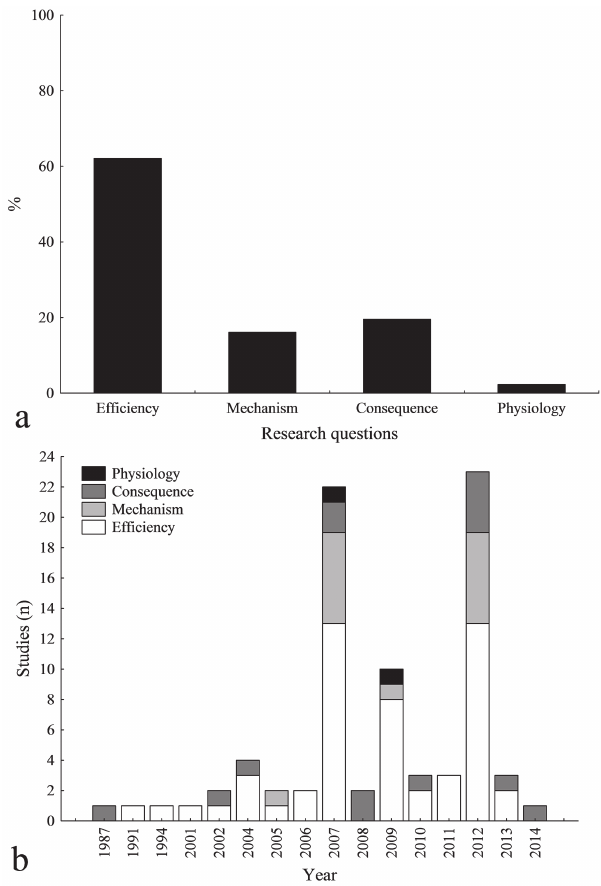
Fig. 7. Research questions addressed by studies, partitioned into categories sensu Roscoe, Hinch (2010). a. proportion of studies that addressed each research question; b. numeric distribution over the